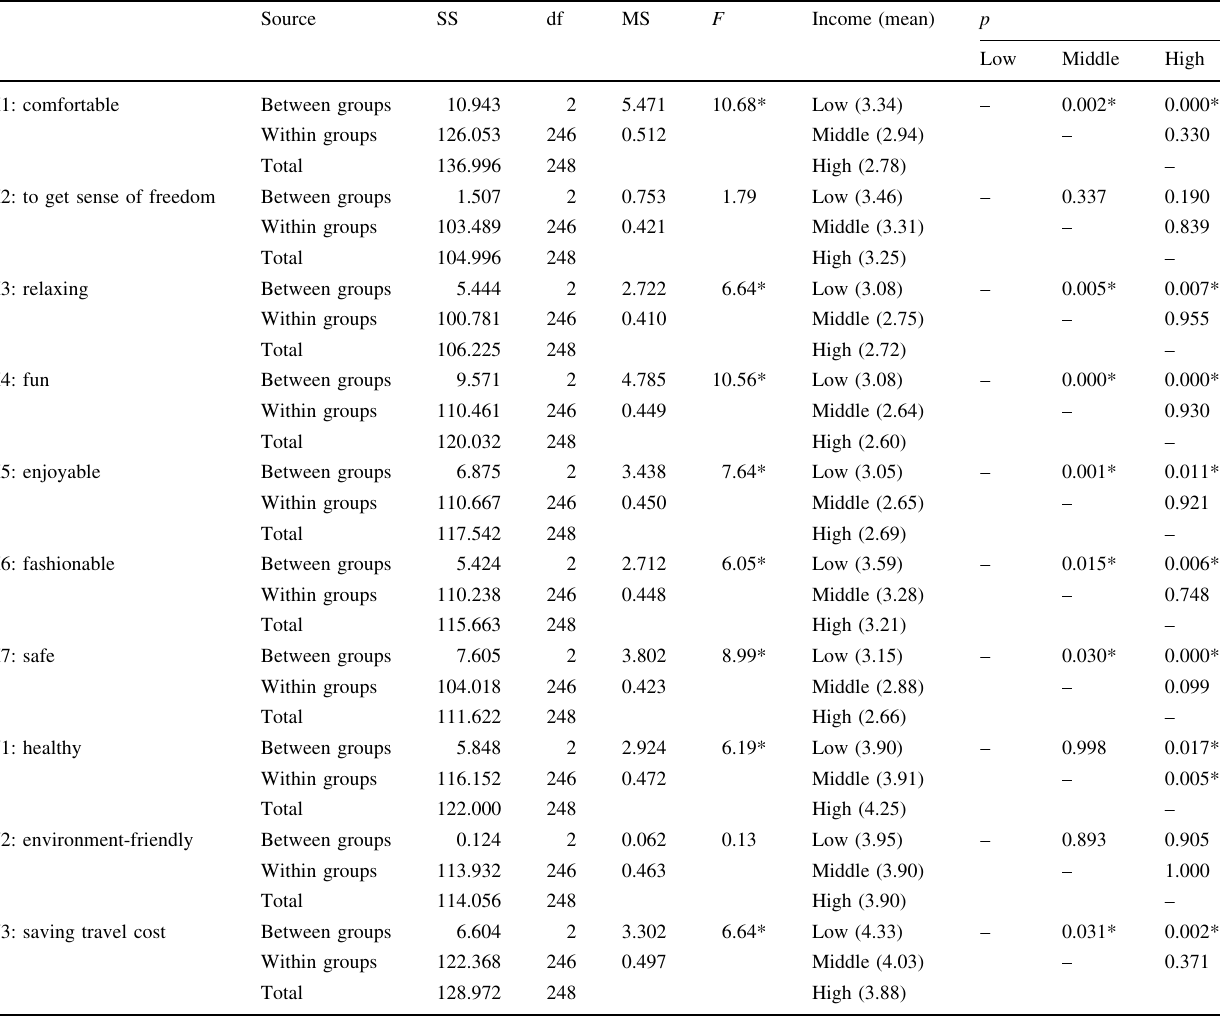
Table 4 Mean difference of attitudes toward walking to transit station in each income group Source